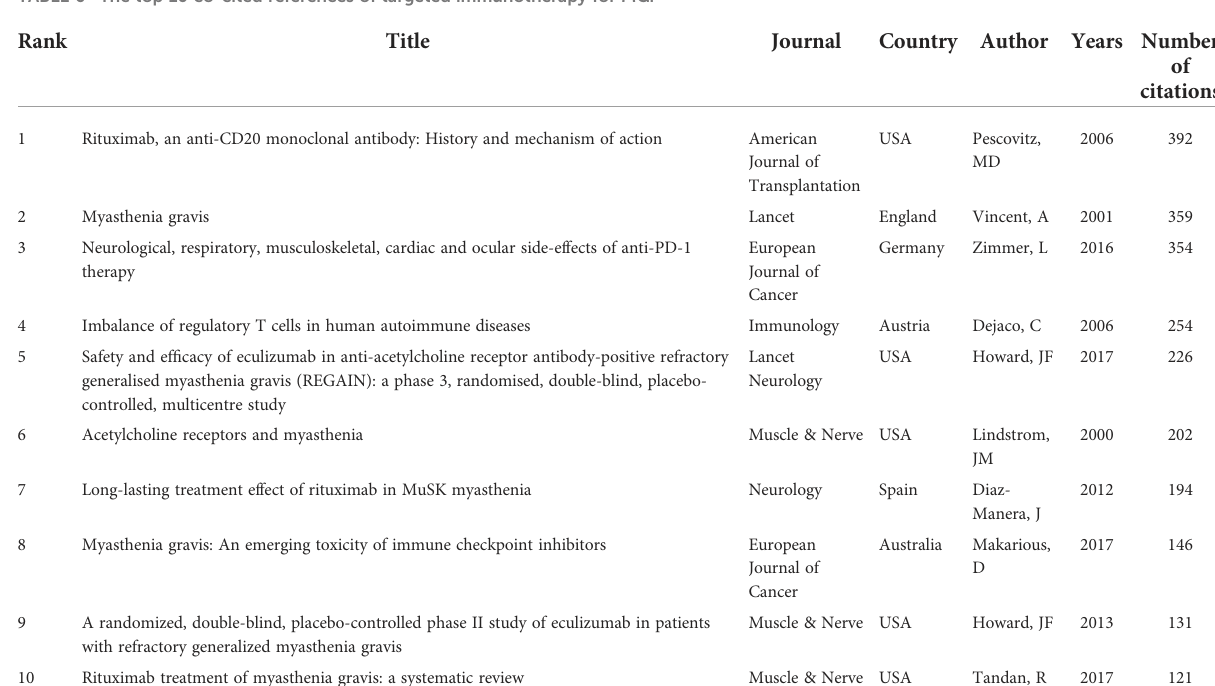
TABLE 6 The top 10 co-cited references of targeted immunotherapy for MG.